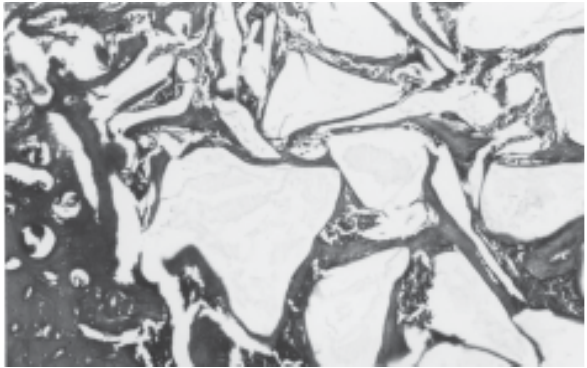
FIGURE 3 - PG 14 days. Larger amount of bone tissue around the particle spaces, with mature aspect (A); bone marrow between trabeculae; remodeling basophilic lines inside the bone tissue (B). HE. Magnification 100x